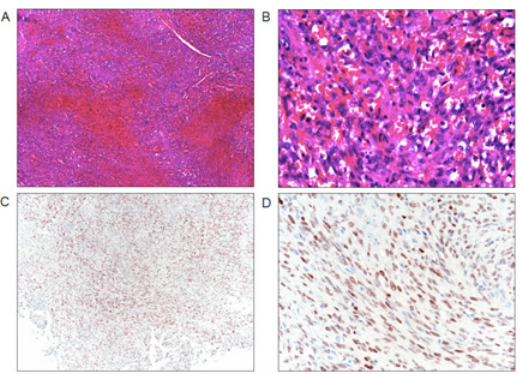
Fig 2. Morphology of KS in a lymph node biopsy. Complete effacement of the nodal architecture by a spindle cell infiltrate at (A) low and (B) high power on hematoxylin and eosin stain that are diffusely positive for the HHV-8 latency-associated nuclear antigen immunohistochemical stain shown at (C) low and (D) high